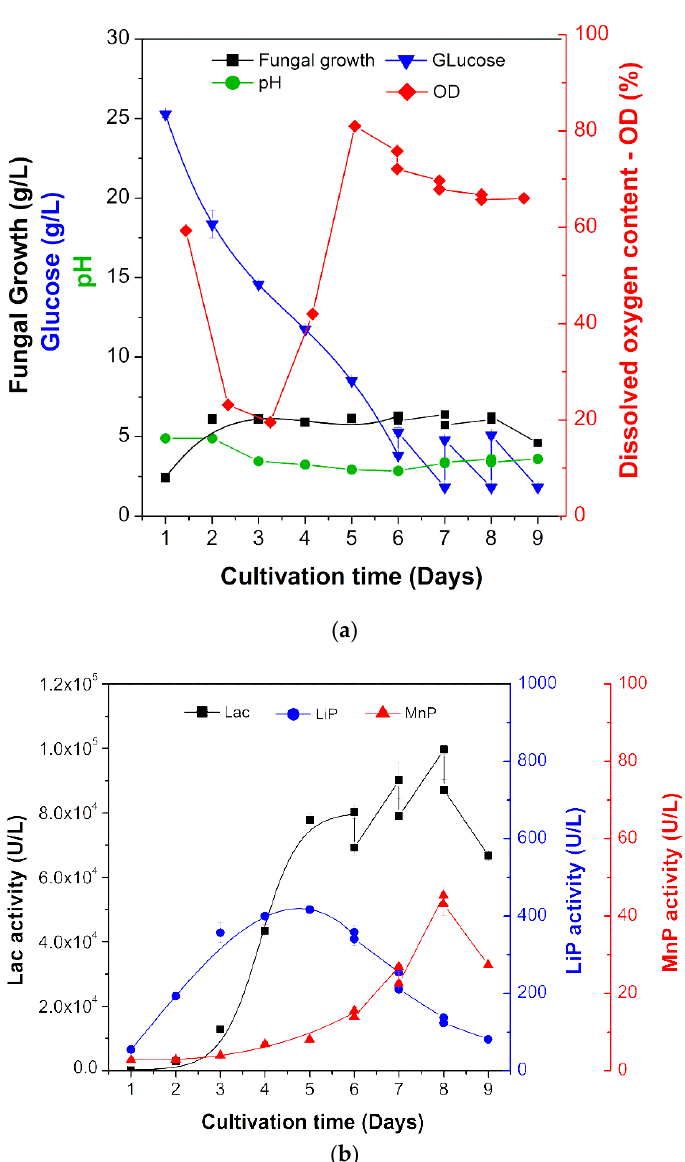
Figure 3. Kinetic growth and enzymatic production of P. sanguineus 2512 in 2L-BCR. ( a ) Time evolution for glucose, biomass, pH and OD, and ( b ) Lac, LiP and MnP activities in the fed-batch culture with three